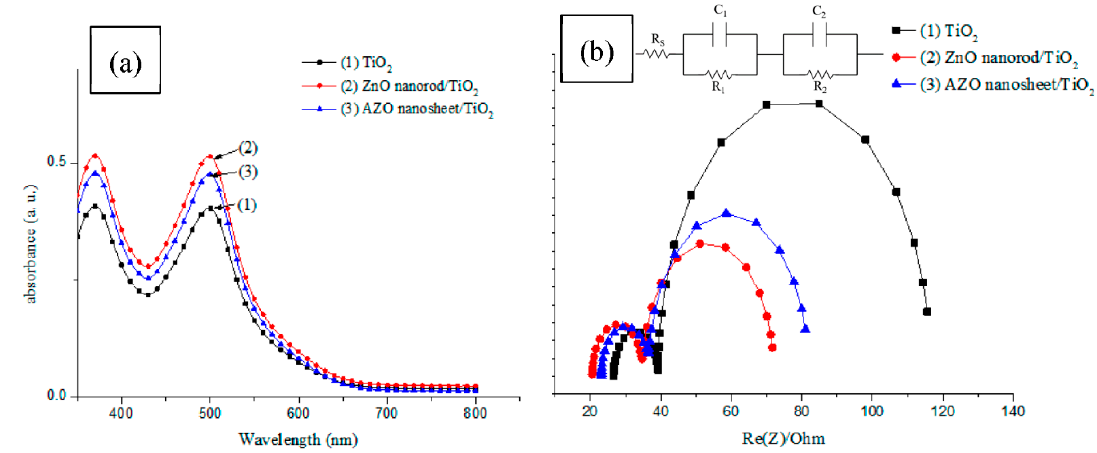
Figure 7. ( a ) Absorption spectra of different photoanodes against ruthenium-535 bis-TBA (N719) dye. ( b ) Nyquist plots of DSSCs with different photoanodes.